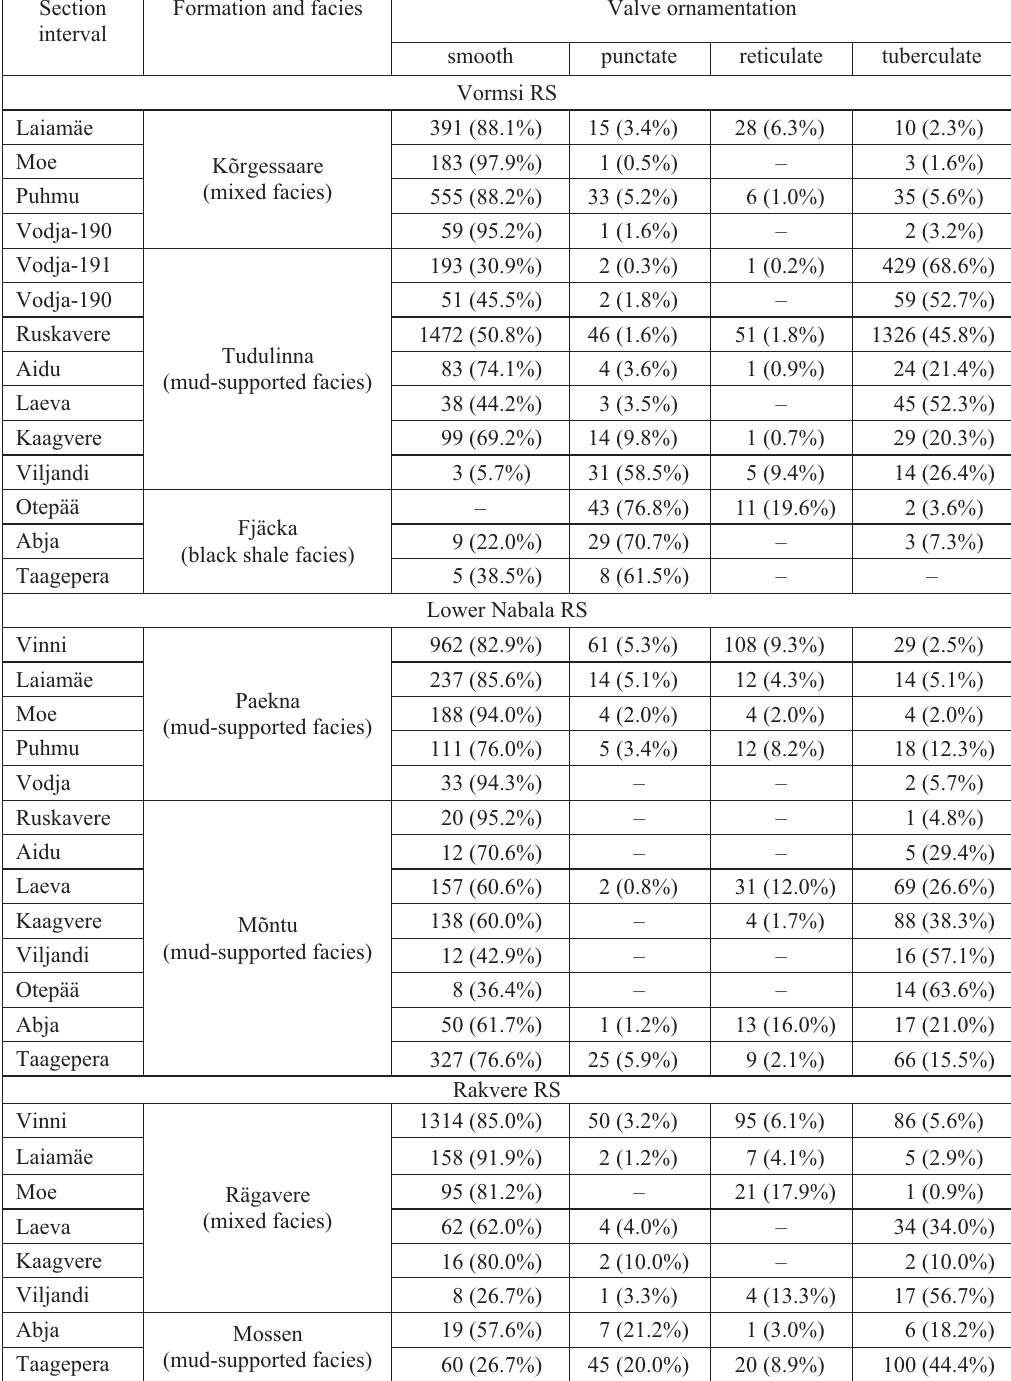
Table 3. Distribution of valve ornamentation (specimen counts and relative abundance in sections and